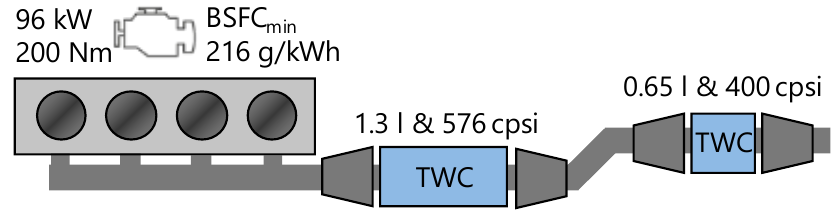
Figure 4. Base engine and exhaust aftertreatment